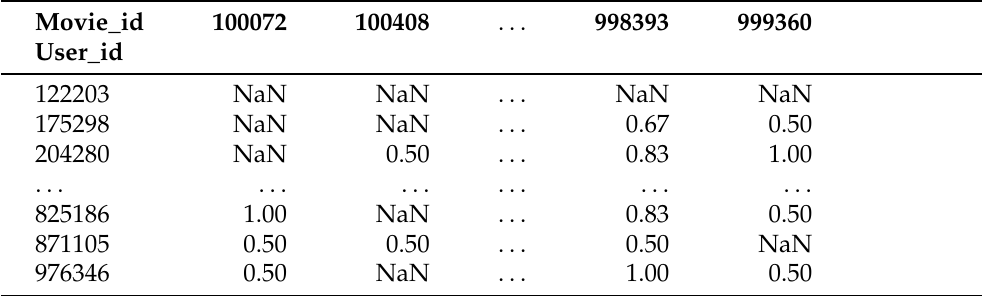
Table 4. Dataframe matrix for affinity showing the ratings from the users with high affinity with the selected user. The shape is (15, 2831), where 15 is the number of users with high affinity and 2831 is the number of